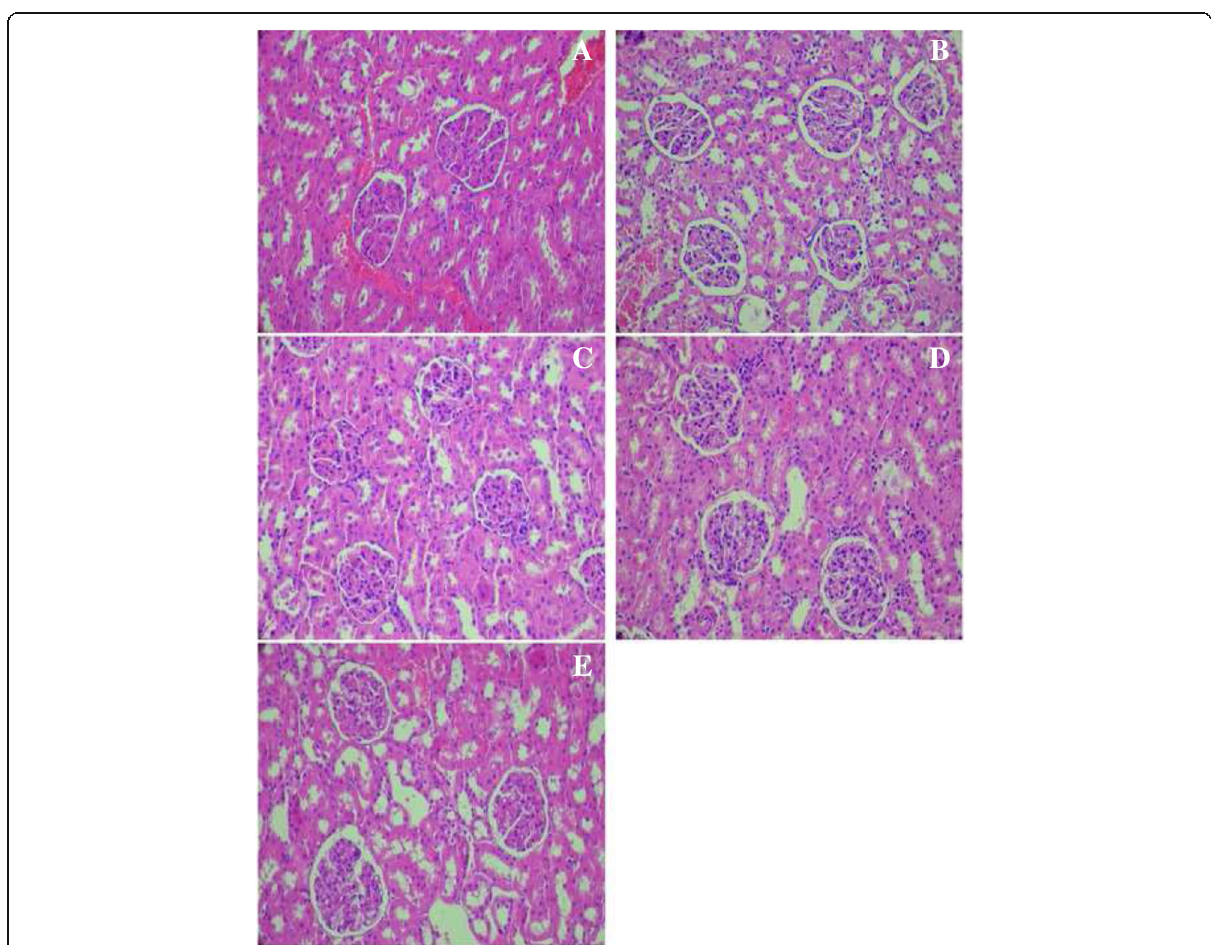
Fig. 8 Histopathological studies of kidney in experimental groups of rats. a Section of the kidney from a control rats showing normal architecture; ( b ) alloxan-diabetic rat showing Bowman ’ s space size and glomerular hypertrophy; ( c-d ) alloxan-diabetic rat treated with the ethanol extract from leaves of C. scolymus at a doses of (200 mg/kg-400 mg/kg) and ( e ); alloxan-diabetic rat treated with acarbose a potential protective effect was shown (H&E ×